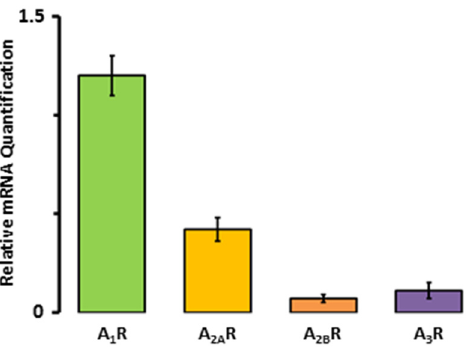
Figure 1. Adenosine receptor mRNA expression in human right atrial tissue samples from seven patients.